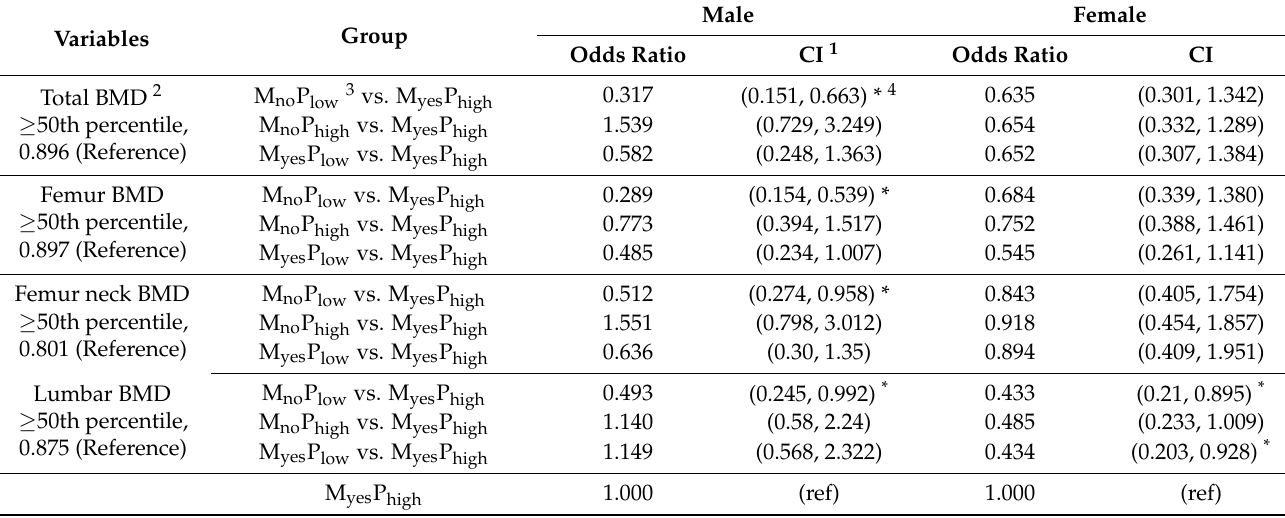
Table 6. Odds ratios on the bone mineral density according to the combination of milk intake and physical activity. Variables